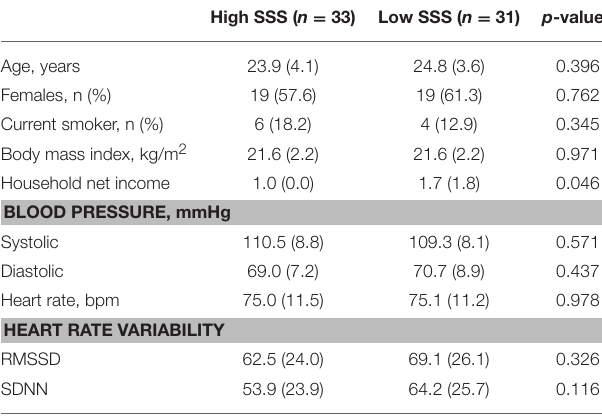
TABLE 1 | Baseline sample